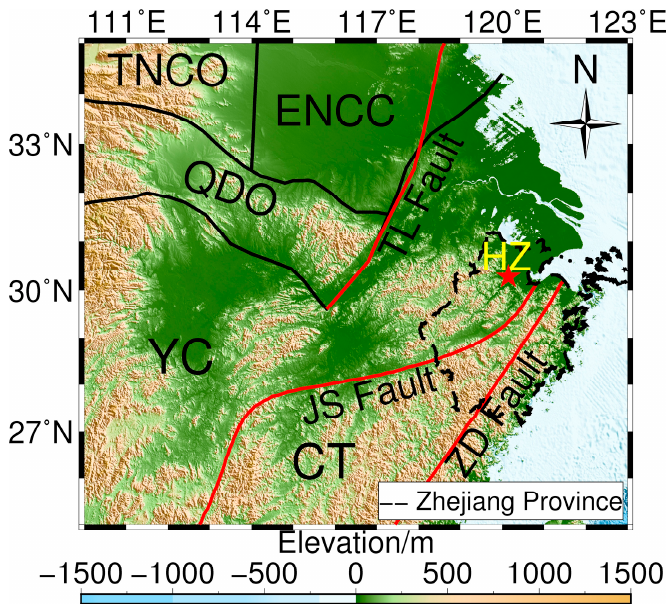
Figure 1. Geotectonic structures in South China Block. The red star indicates the location of the West Lake. The black dashed line represents the boundary of Zhejiang province. The abbreviations are: Trans-North China Orogen (TNCO), Eastern North China Craton (ENCC), Qinling–Dabie Orogen (QDO), Yangtze Craton (YC), Cathaysia Terrane (CT), Tanlu Fault (TL Fault), Jiangshan–Shaoxing Fault (JS Fault), Zhenghe–Dapu Fault (ZD Fault), Hangzhou